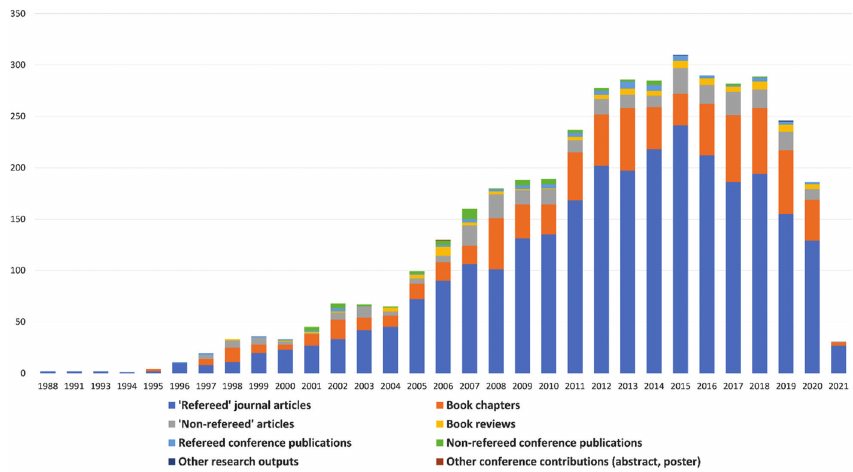
Fig. 2: Yearly number of short works at Utrecht University released under Article 25fa (February 2019–1st January